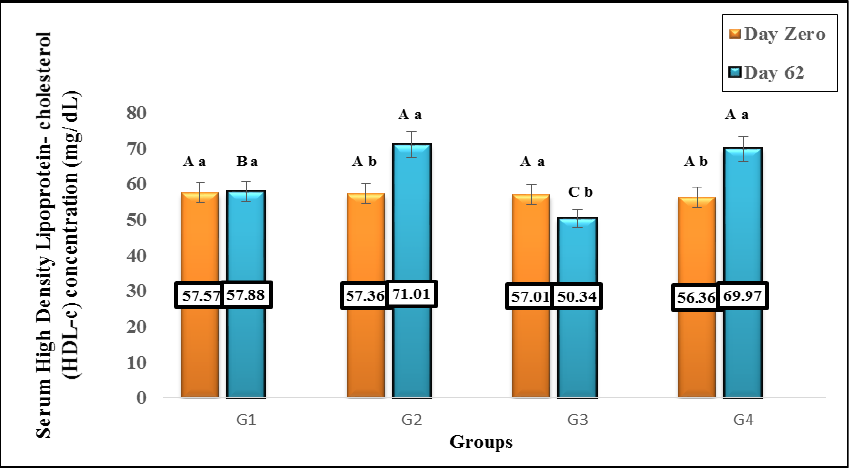
Figure 7. Effect of phosphatidylcholine, fructose and/or combination on serum high density lipoprotein-cholesterol (HDL-c) concentration (mg/dL). Mean ± SE, n = 9 in a group. G1 control groups (C), G2: (Pc), G3: (Fr), G4: (Fr + Pc). A-C Significant variations P ≤0.05 between peroids